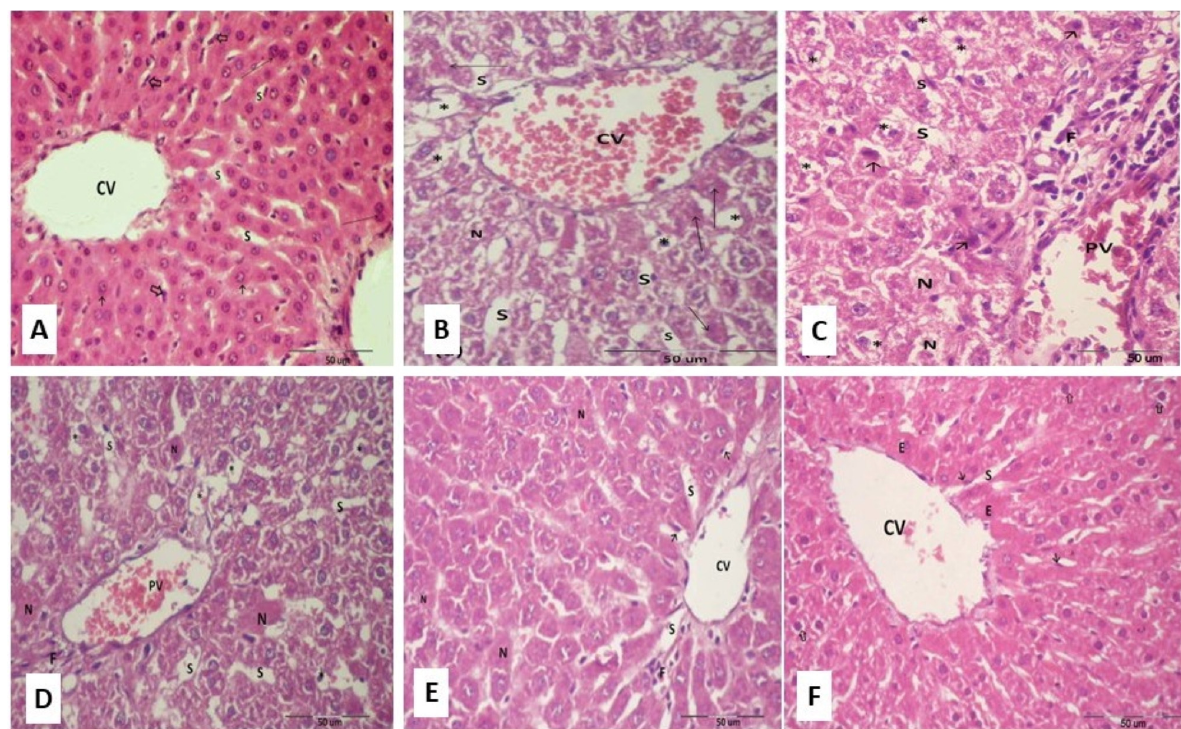
Figure 8. Photomicrographs of liver sections stained with hematoxylin and eosin stain. ( A ) Section of normal control rat showing normal hepatocytes with central vein (CV), sinusoids (S) and Kupffer cells ( ). Note mononucleated ( ↑ ) and binucleated hepatocytes (thin arrow). ( B , C ) Liver sections of obese rat showing fatty degeneration (steatosis); where hepatocytes have ballooned clear cytoplasm (*), wide sinusoids (S), apoptotic figures ( ), necrosis (N), and increased eosinophilia (E) in some hepatocytes. ( D – F ) Liver section of obese rat after chrysin treatments with increasing doses (25, 50, and 75 mg/Kg/day, respectively) showing sinusoidal dilatation (S) around central vein (CV) with minimal congestion in sinusoids (thin arrow) and well-defined Kupffer cells and low numbers of fatty hepatocytes and apoptotic figures.